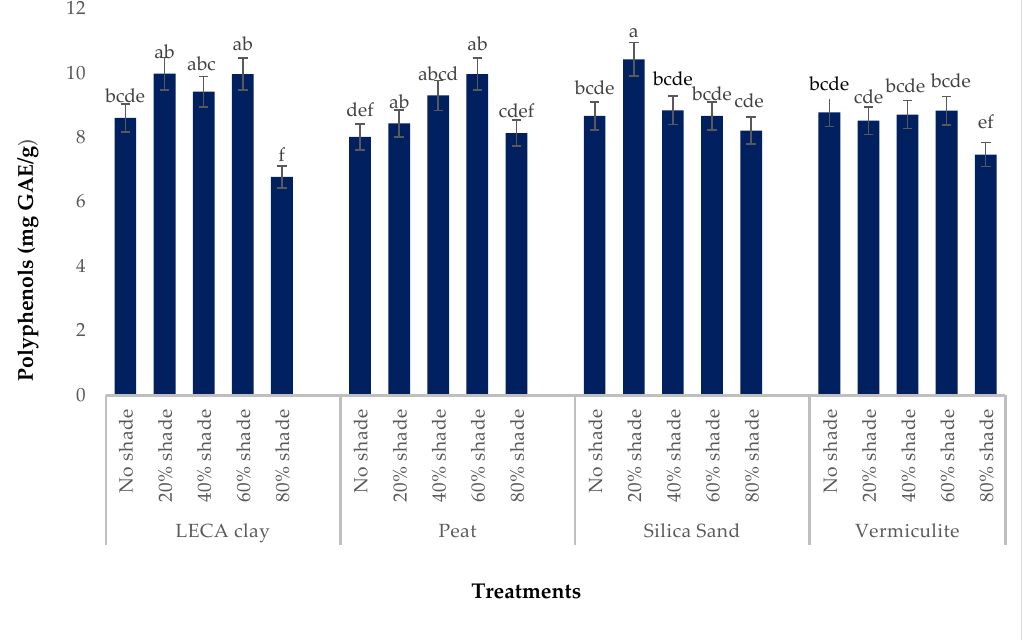
Figure 6. The effect of different growth media and shade levels on total polyphenols in the flower buds of T. divaricata . Means followed by the same letter did not differ by Tukey’s test ( p > 0.05).